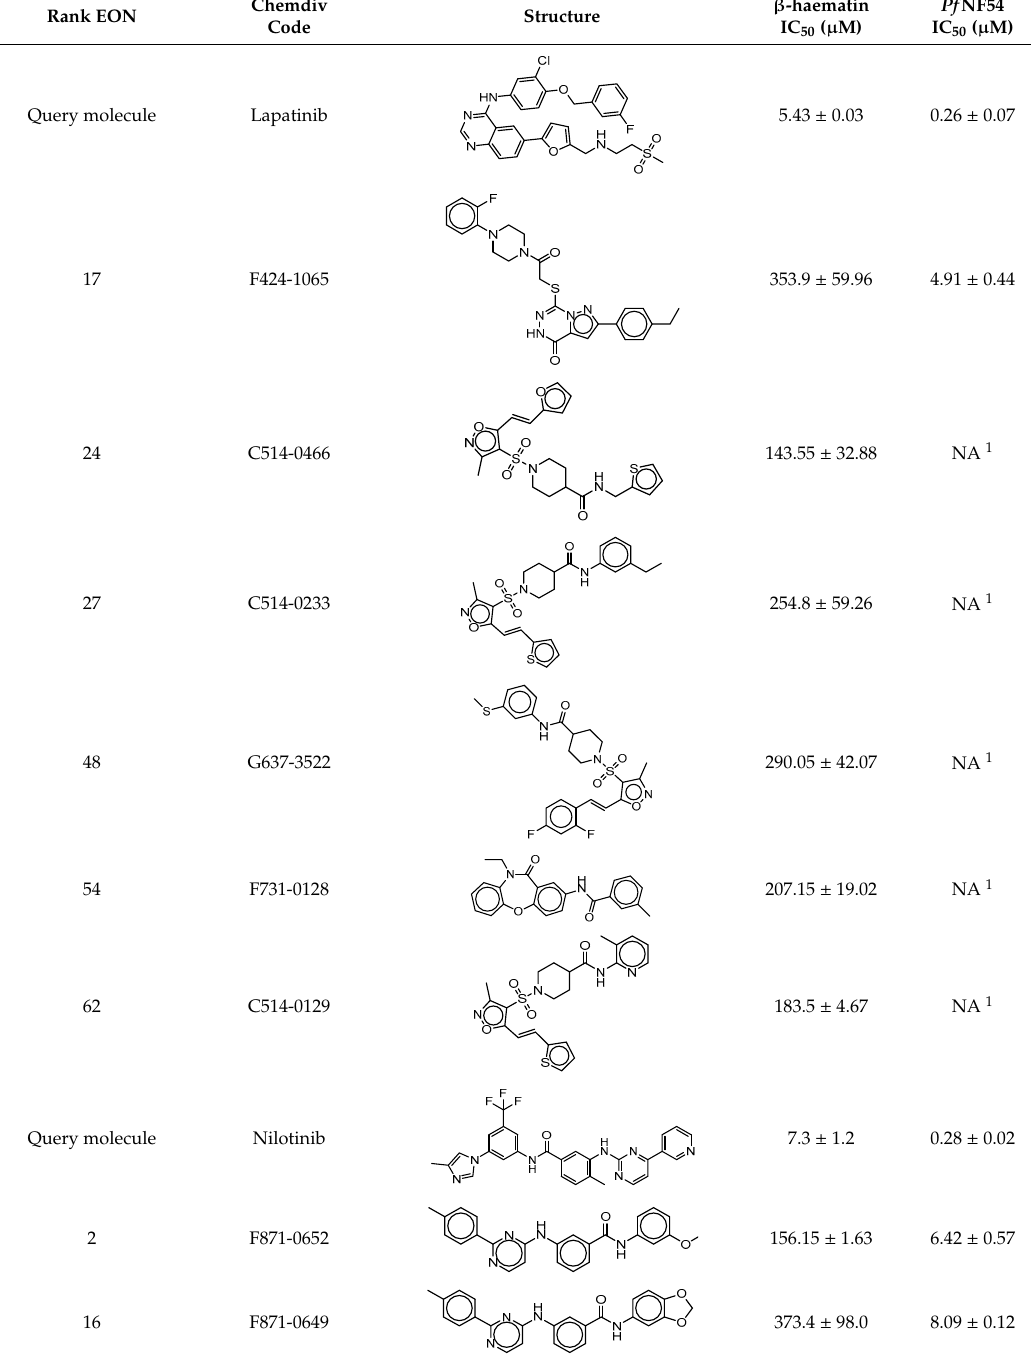
Table 3. The LBVS hits and their structures followed by experimental β -haematin formation inhibition and parasite growth inhibition IC 50 data in the CQ-sensitive ( Pf NF54) strain of P. falciparum . Rank